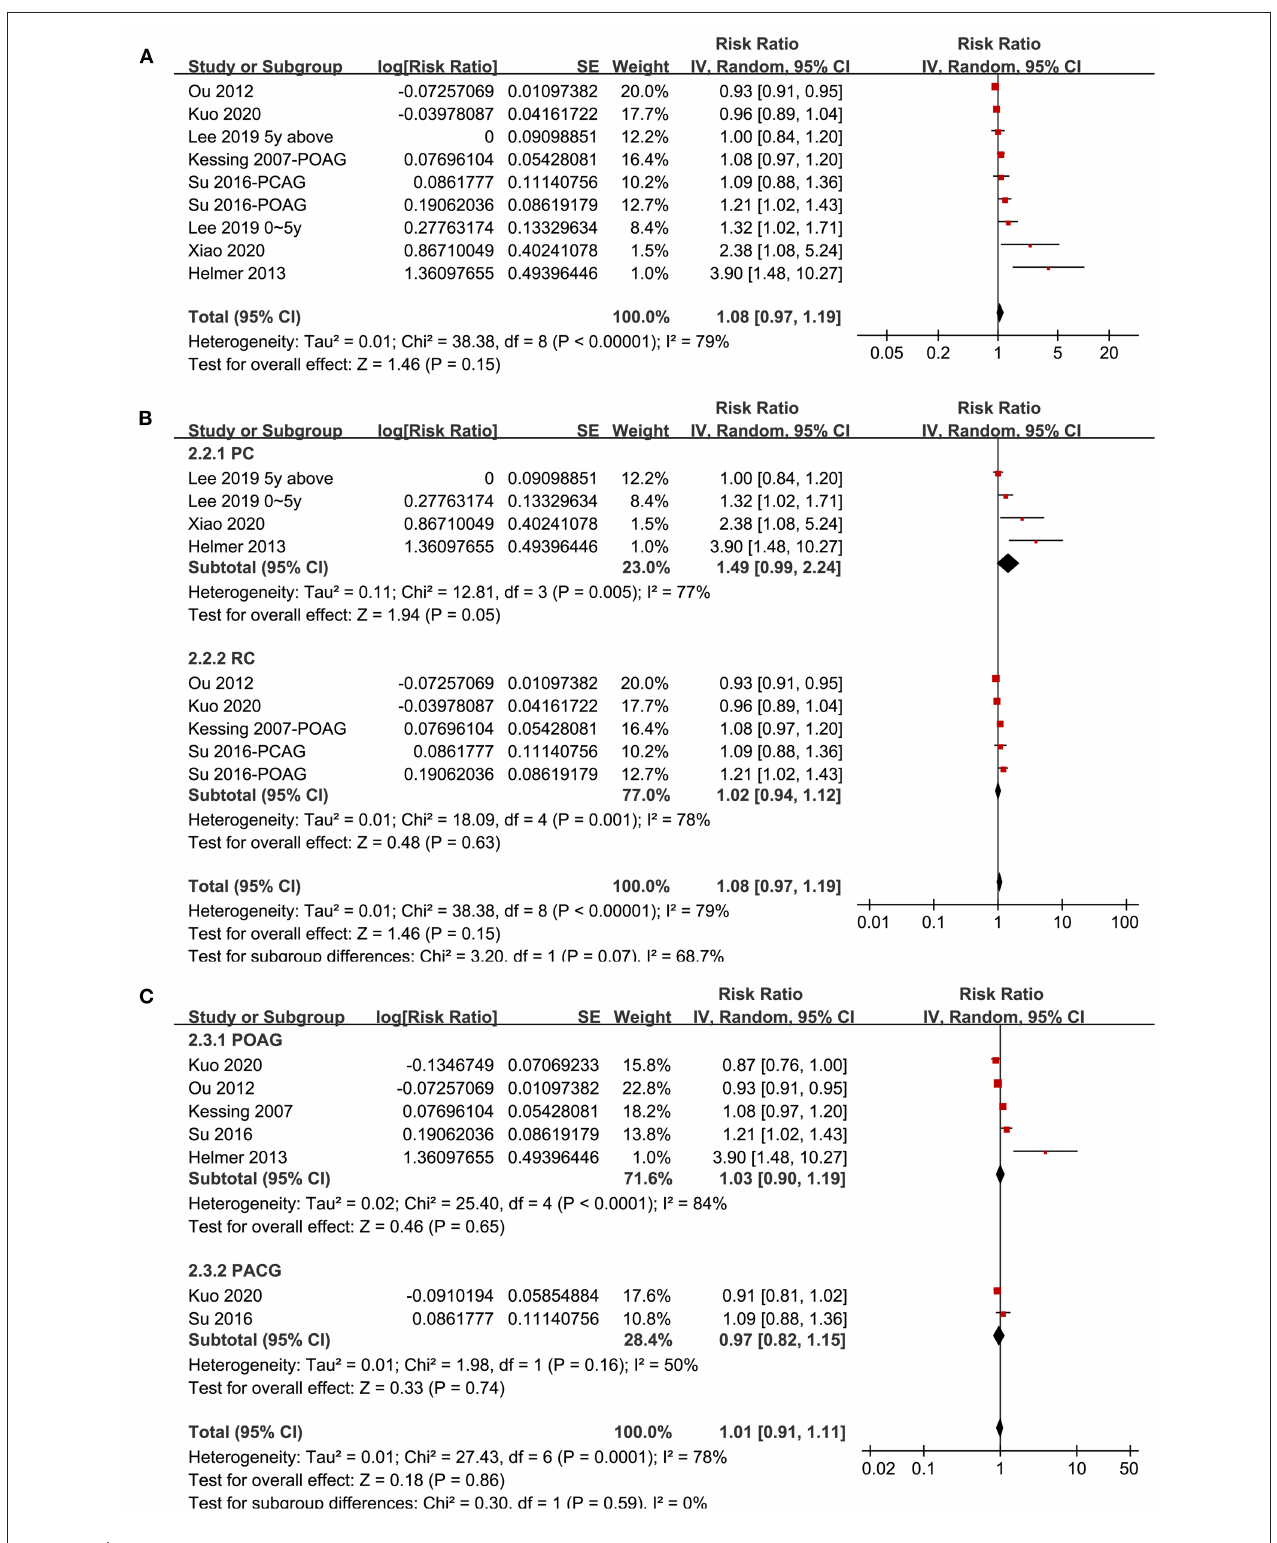
FIGURE 3 | Forest plots for the meta-analysis of the association between glaucoma and the incidence of all-cause dementia in adult population; (A) overall meta-analysis; (B) subgroup analysis according to the study design; and (C) subgroup analysis according to the type of glaucoma.